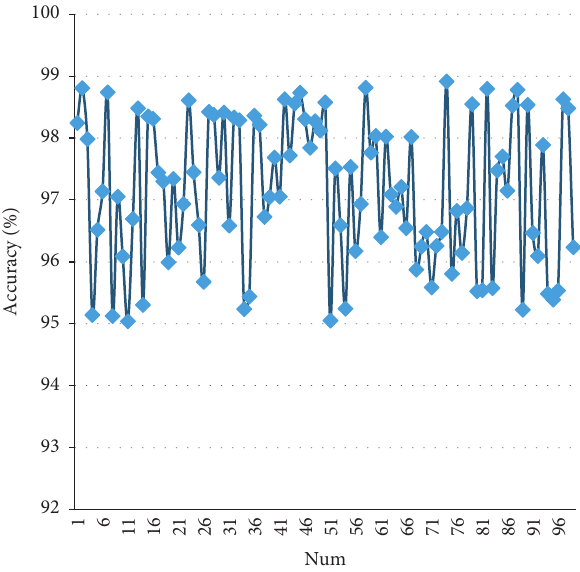
Figure 12: Statistical diagram of the accuracy of image recognition of mobile phone core wires.